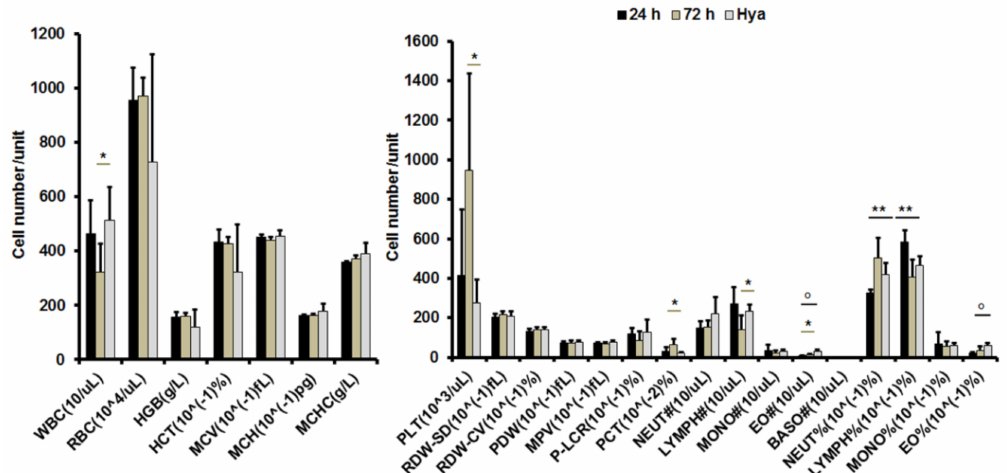
Figure 8. Comparative analysis of blood components of mice at day 30 after magnetic hyperthermia treatment without or with pretreatment with hyaluronidase. Each bar depicts the mean of blood components collected from n = 4 mice for the 24 h and Hya/24 h groups and n = 5 for the 72 h group and the respective standard deviations. * p < 0.05 for decreased white blood cells (WBC) and lymphocytes concentration (LYMPH#) in 72 h compared to the 24 h and Hya/24 h group and also increased platelets (PLT), platelet volume (PCT), and eosinophil concentration (EO#) in the 72 h versus Hya/24 h group. ** p ≤ 0.02 for lower percent of neutrophils (NEUT%) and higher percentage of lymphocytes (LYMPH%) in the 24 h compared to the Hya/24 h and 72 h groups. ◦ p < 0.01 for higher concentration and percentage of eosinophils (EO# and EO%) in the Hya/24 h compared to the 24 h